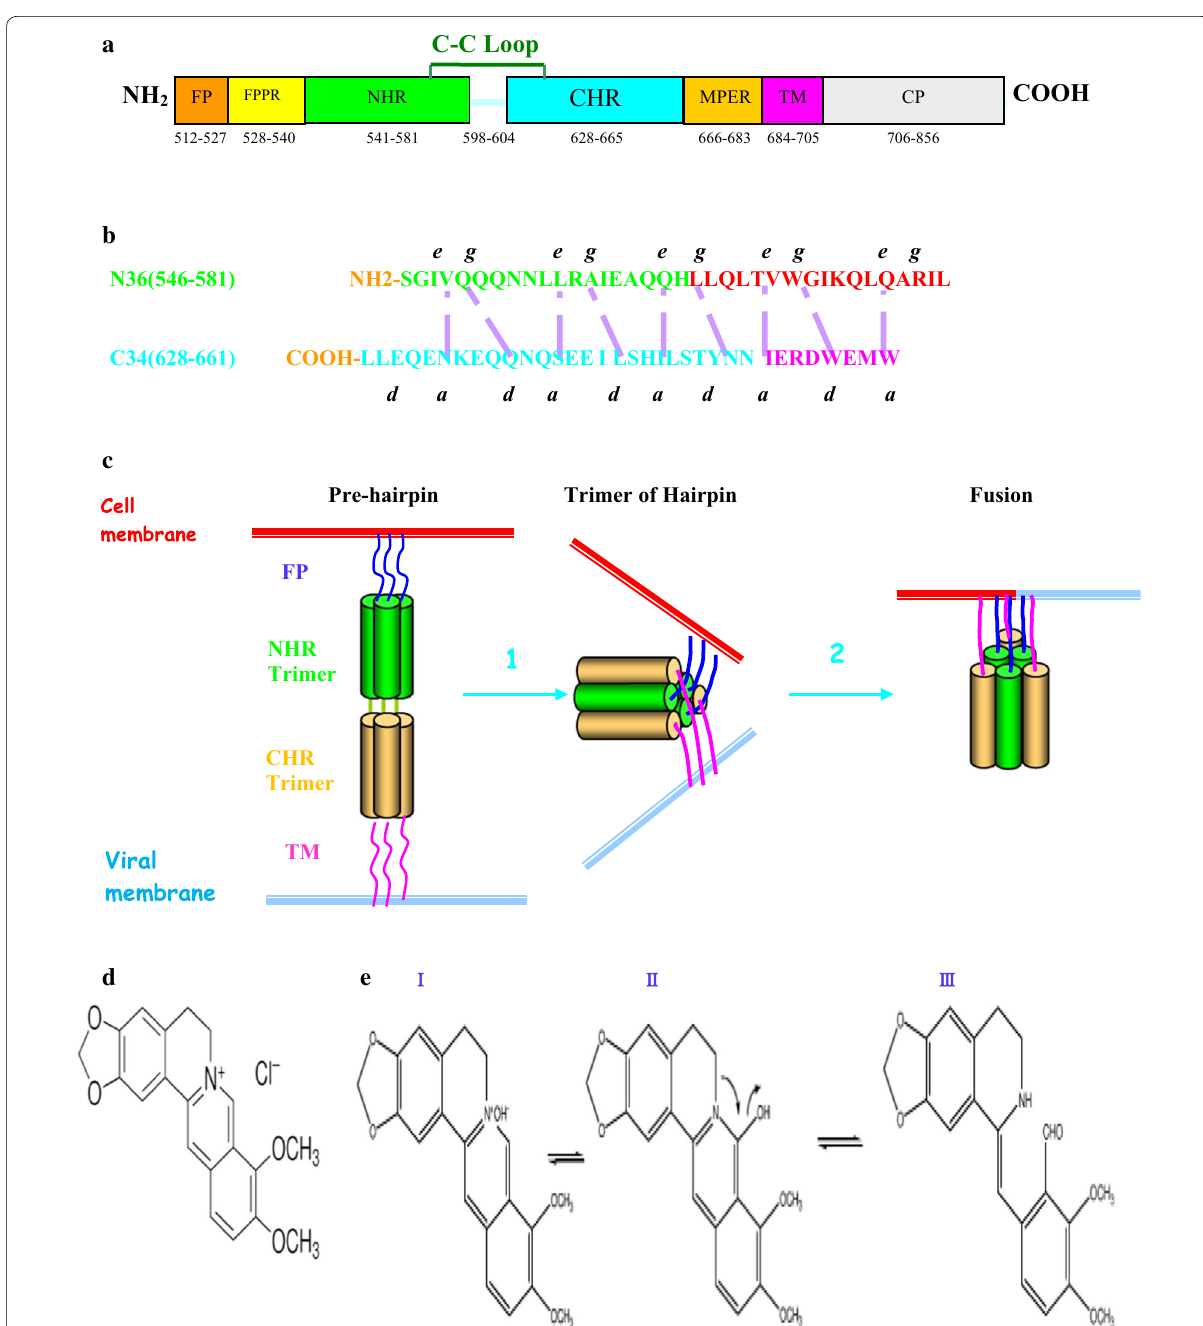
Fig. 1 Schematic diagram of HIV-1 gp41. A The functional domains of gp41 are indicated, respectively. Residues are numbered corresponding to their positions in HIV-1 HXB2 gp160. B The interactions between N36 and C34 of HIV-1 gp41. The purple dashed lines between N36 and C34 indicate the interactions between the residues located at the e and g positions in the NHR and a and d positions in the CHR of gp41, respectively. The N36 and C34 sequences are highlighted in green and blue, respectively. The pocket-forming sequence (aa565–581) in N36 and the pocket-binding domain (aa628–635) in C34 are colored in red and pink, respectively. C Three steps of HIV-1 entry: pre-hairpin, trimer-of-hairpins, and a stable six-helix bundle core structure. The NHR and CHR helices of gp41 are colored in green and orange, respectively. The 6HB structure is composed of three central NHR helices (green surface) surrounded by three antiparallel CHR helices (orange surface). D The chemical structure of berberine. The positively charged nitrogen is indicated. Molecular weight of berberine 371.8, molecular formula: C20H18ClNO4. = E The conformational change of berberine. The isomerism qualifies as tautomerism: (I) quaternary-berberine, (II) alcoholic-berberine, (III)